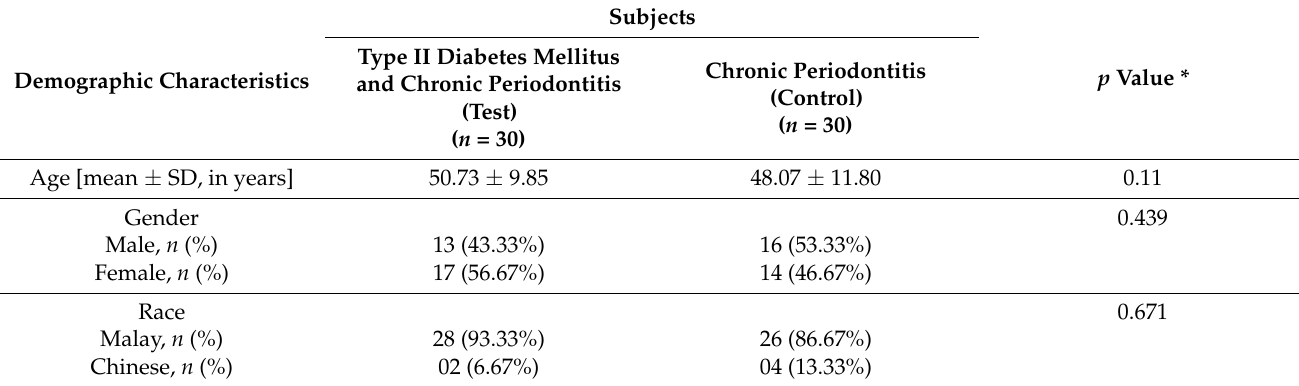
Table 1. Demographic analysis of